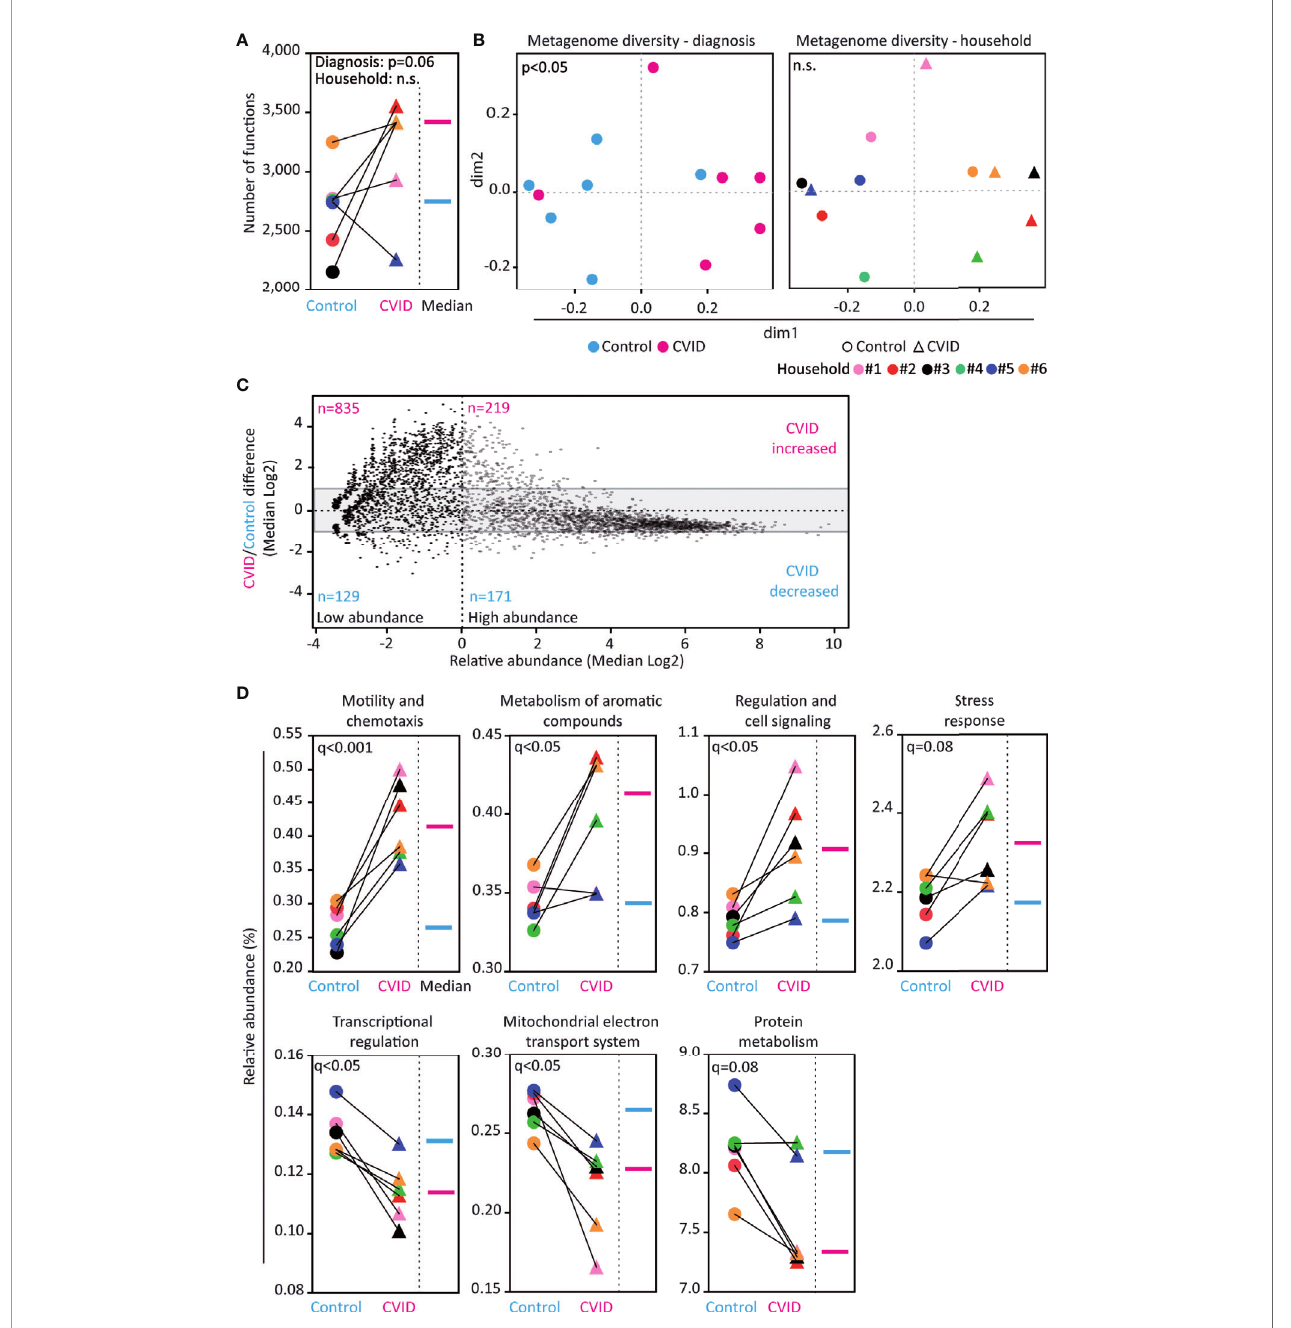
FIGURE 3 | Fecal microbiome of CVID patients shows differences in genetic functions. (A, B) CVID patients have more database-identi fi ed genetic functions than healthy housemates (p=0.06). The functional metagenome associates with the diagnosis of CVID and not with household. (C) Composition of genes in the CVID metagenome differ from the metagenome of healthy controls. The CVID metagenome was enriched for low-abundance genes (see upper left corner). The grey area (-1 to +1) contains genes with similar abundance between groups (i.e., fold change lower than two). Based on the value of relative abundance 1 (dashed vertical line), the genes were classi fi ed as low-abundance (left dimension) and high-abundance (right dimension). (D) Relative abundance of functional groups within the metagenomes. Five functions showed signi fi cantly different abundance between the groups (q<0.05) and two other functions showed a corresponding trend (0.05<q<0.1). Unpaired Mann-Whitney (for Diagnosis) and paired Wilcoxon tests (for Household) (A) , Chao dissimilarity matrix, NMDS plot, and nonparametric test ANOSIM (B) , ALDeX2 method (Analysis of differential abundance taking sample variation into account) (C) , and DESeq2 method (D) were used to calculate the statistical differences. Database SEED level 3 (A – C) and level 1 (D) was used for functional analysis. The complete analysis of functional diversity, including a list of relative abundancies, is shown in Figure S1 , Table S3 , and Table S5